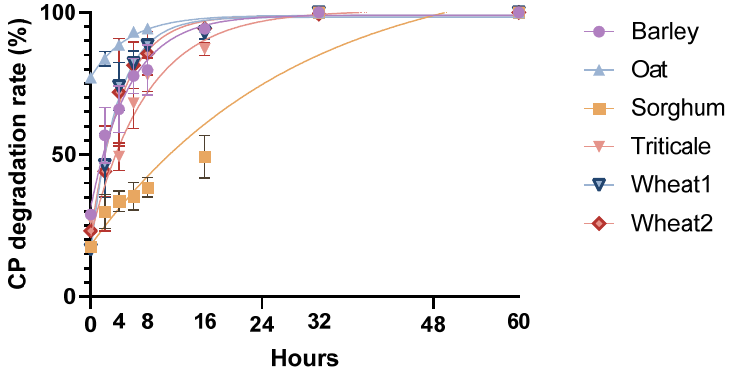
Figure 3. In situ disappearance pattern of CP (crude protein) in six ground grains.